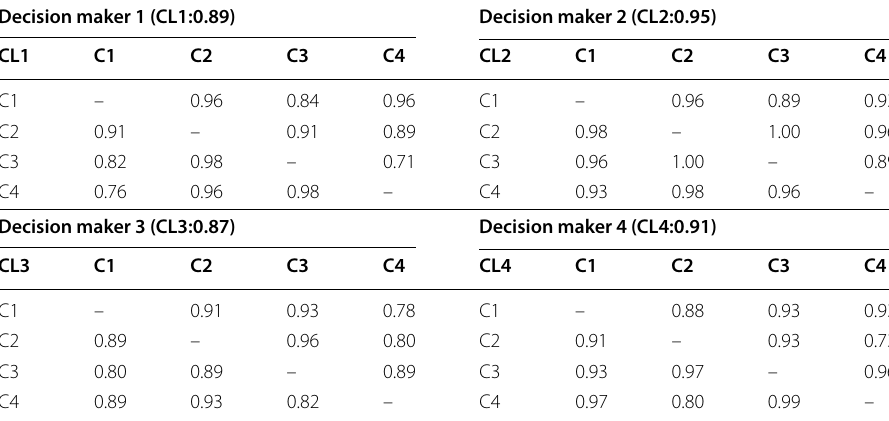
Table 5 Consistency levels for the equity-based crowdfunding alternative Decision maker 1